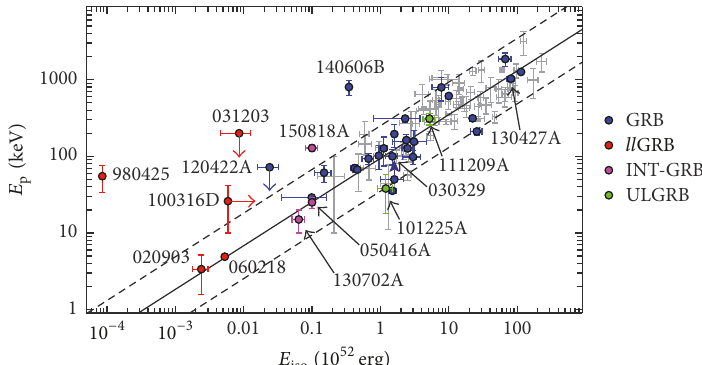
Figure 8: Properties of the prompt emission for different classes of GRBs in the 𝐸 훾, along with their best fit to a single power law (index of 𝛼 = 0.57 ) and the 2 𝜎 uncertainty in their fit. Notable events that do not appear to follow the Amati relation include 𝑙𝑙 GRBs (980425 and 031203), INT-GRBs (150818A), and high-luminosity GRB 140606B. Both ULGRBs are consistent with the Amati relation, so are GRBs 030329 and 130427A, while GRB 120422A and 𝑙𝑙 GRB 100316D are marginally consistent.